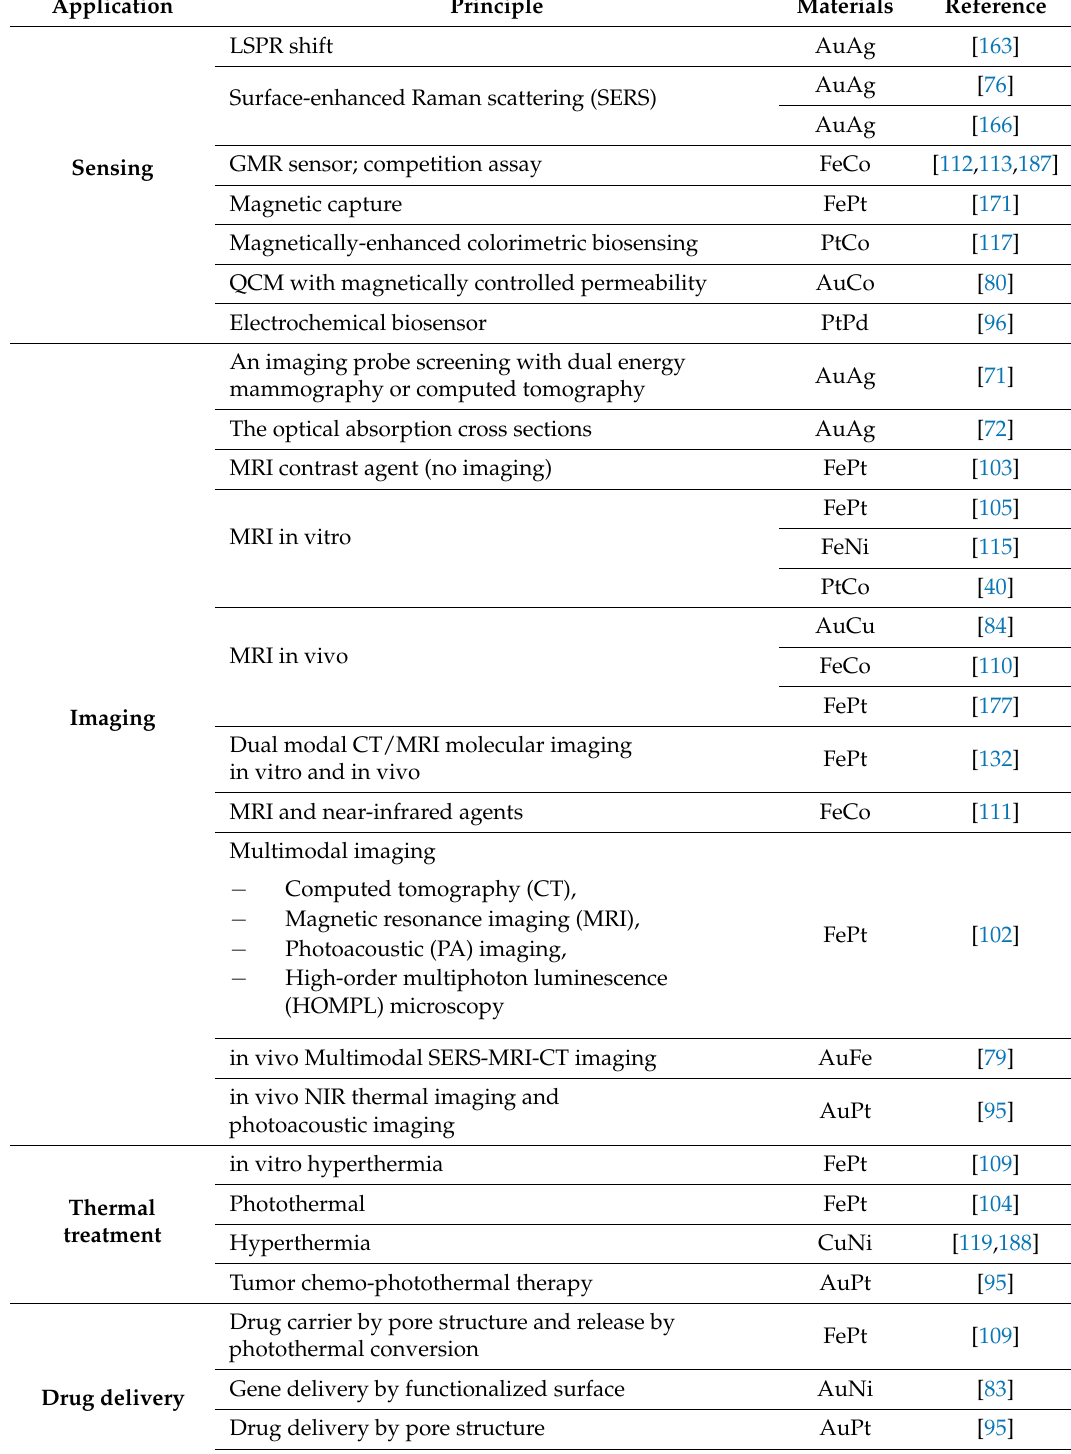
Table 2. Bimetallic nanoparticles in biological